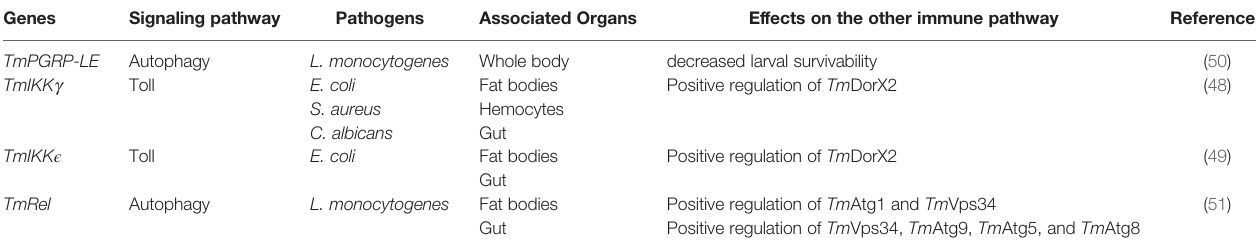
TABLE 2 | Potential evidence for the interactions between Imd pathway and other immune signaling pathways in T. molitor . Genes